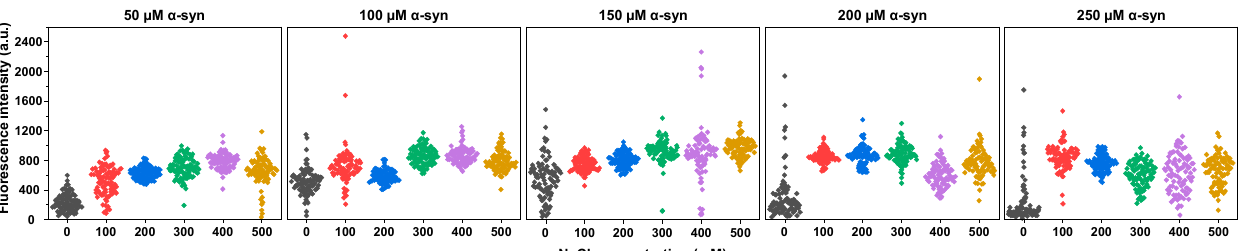
Figure A1. α -syn sample bound-ThT fluorescence intensity distribution at different ionic strength and protein concentra- tion conditions.